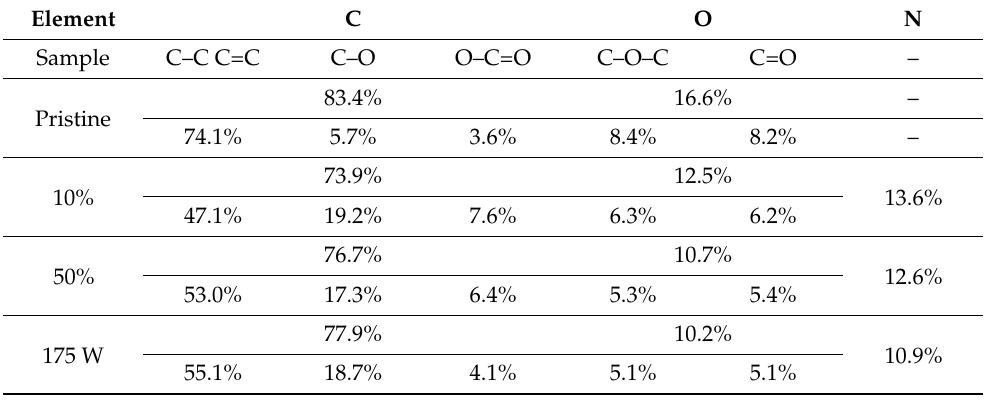
Table 3. Atomic composition of the samples determined by XPS. The composition is expressed in percentage, the analysis was performed on PET, 10% PPOLs, 50% PPOLs and 175 W PPOLs. The experimental uncertainty of the reported atomic composition values does not exceed ± 5%.